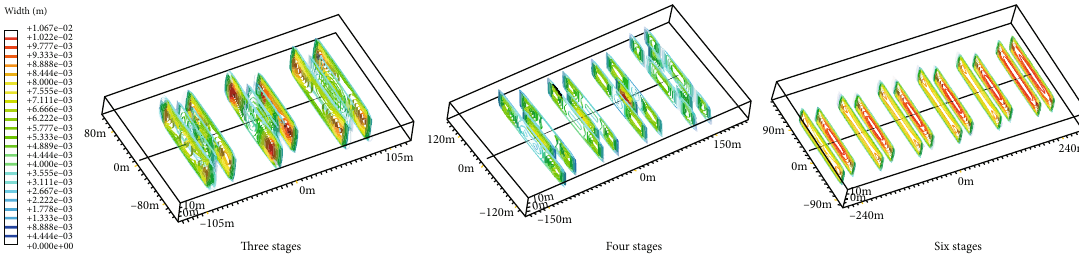
Figure 4: Fracture geometries of di ff erent stage